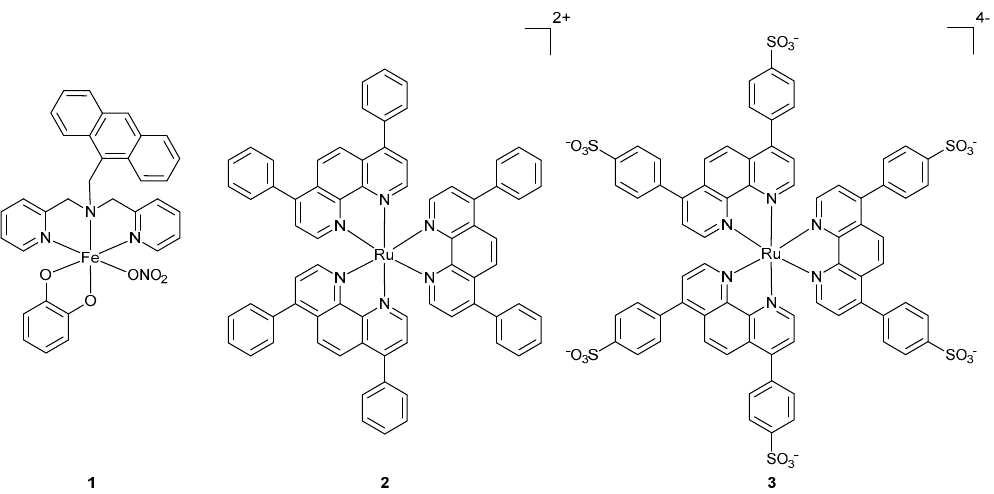
Figure 1. Chemical structures of a Fe(III) complex ( 1 ) investigated by Chakravarty and co-workers and Ru(II) bphen complexes ( 2 , 3 ) investigated by Glazer and co-workers as Photodynamic Therapy photosensitizers (PDT PSs).